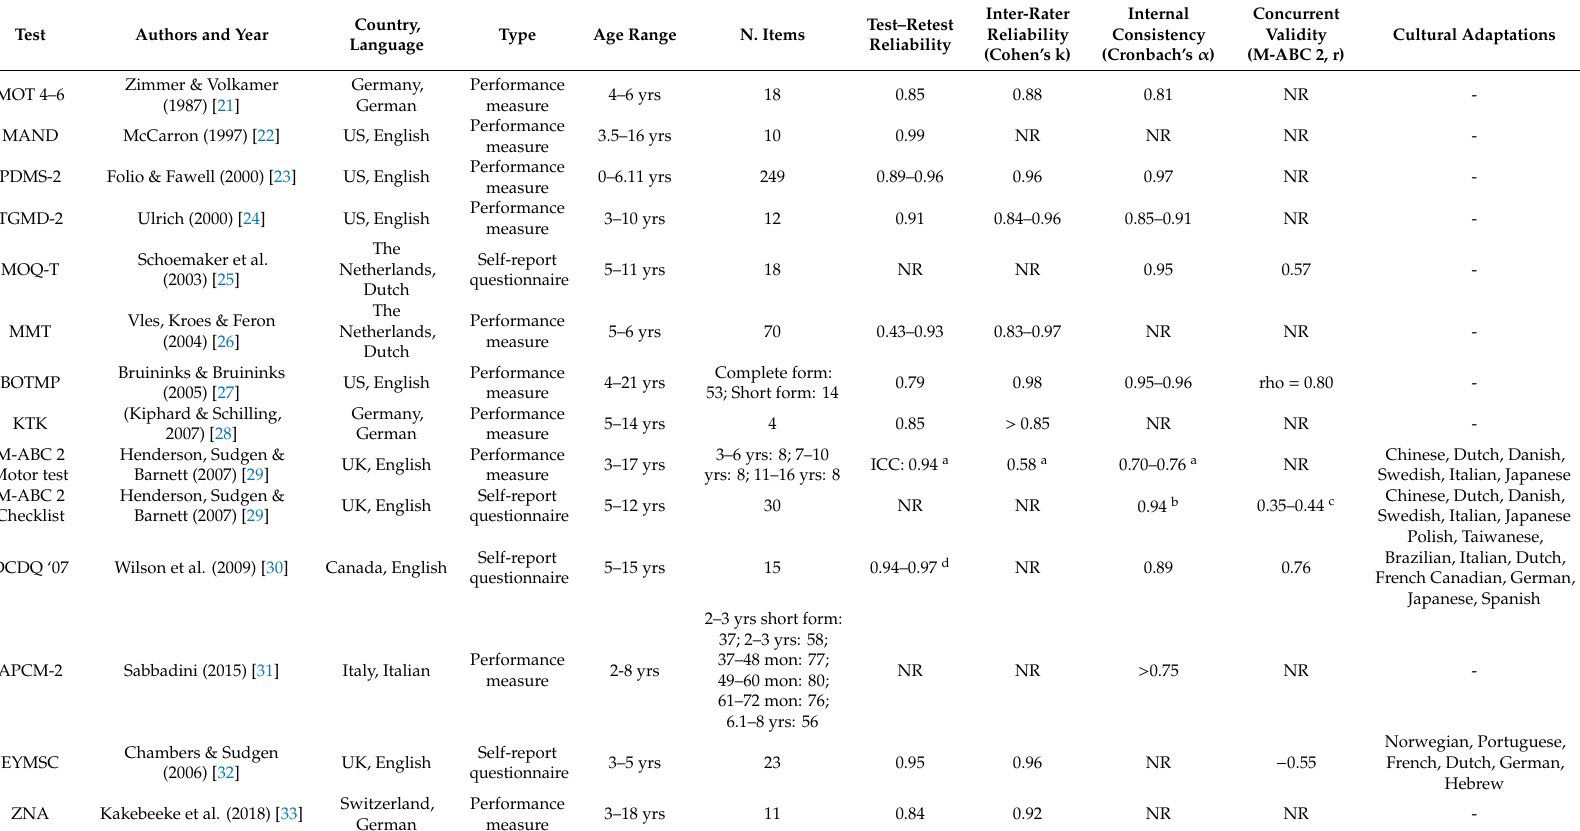
Table 1. Motor coordination tests for children (i.e., checklists and motor performance